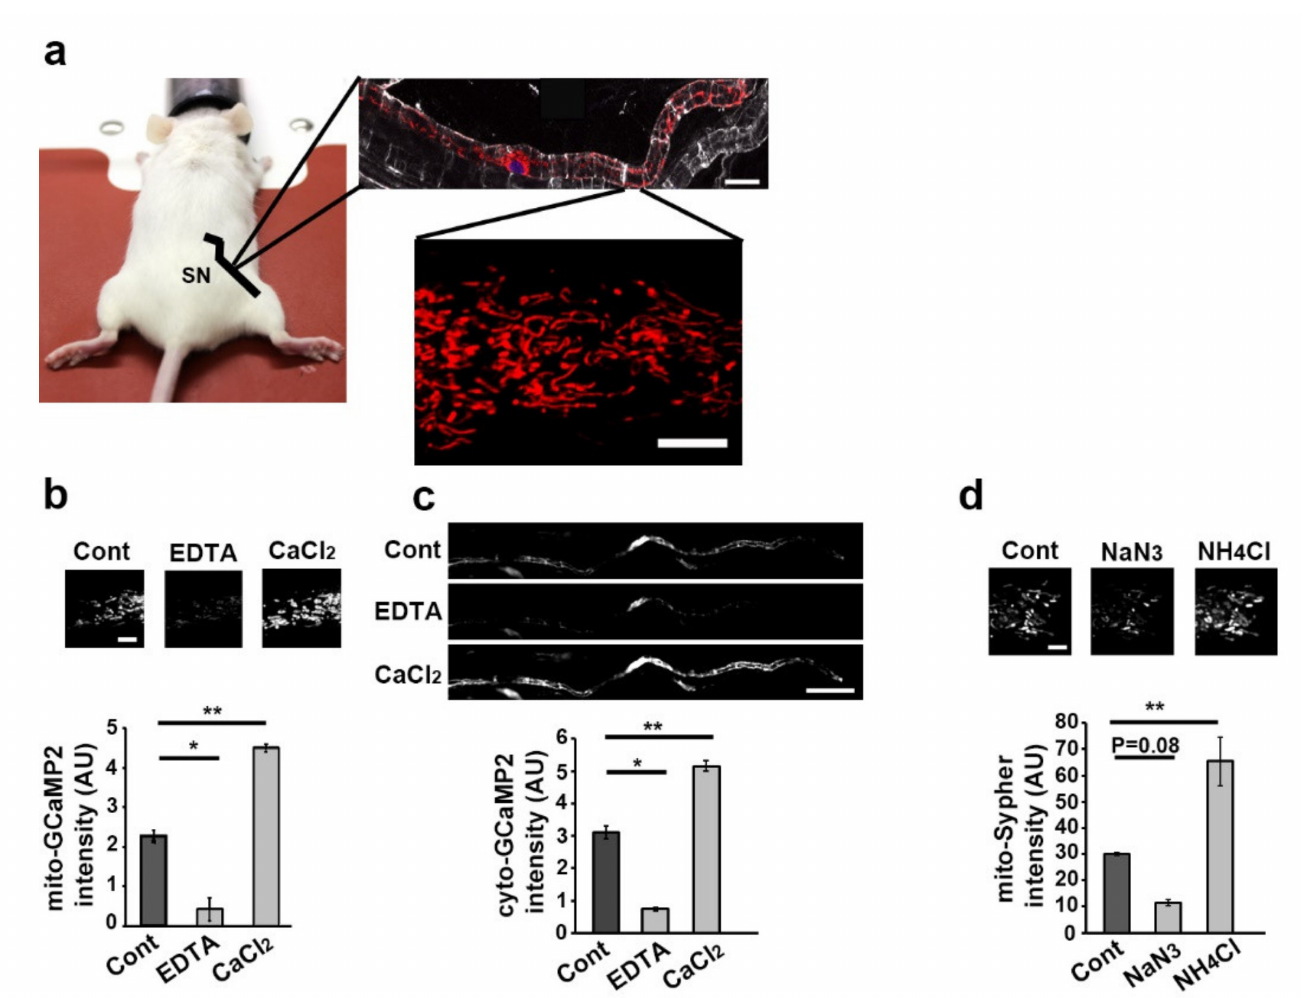
Figure 1. Live imaging technique and fluorescent probes validation ( a )—Schematic representation of the imaging technique used in this work. The sciatic nerve (SN) of anesthetized mice illustrated by the black line was exposed under the lens of a multiphoton microscope. Myelinating SC, stained for E-cadherin (white), contains mitochondria labelled through adenovirus-delivered mito-Dsred2 expression (red) in particular around the cell nucleus labelled with TOPRO3 (blue) (scale bar= 10 µ m). This technique allows the selective in vivo multiphoton imaging of mitochondria in some parts of living SC (scale bar = 5 µ m. Same magnification for all pictures.). All mice were 8 to 11 weeks old. ( b ) Mouse sciatic nerves expressing mito-GCaMP2 were incubated in a bath containing Leibovitz’s L15 medium without (Cont) or with EDTA (1 mM) or calcium chloride (CaCl 2 , 100 µ M). Probe fluorescence was imaged (upper panels pictures, scale bar = 5 µ m. Same magnification for all pictures.) and measured (lower panel graph). ( c ) Mouse sciatic nerves expressing cyto-GCaMP2 were incubated in a bath containing Leibovitz’s L15 medium without (Cont) or with EDTA (1 mM) or calcium chloride (CaCl 2 , 100 µ M). Probe fluorescence was imaged (upper panels pictures, scale bar = 50 µ m. Same magnification for all pictures.) and measured (lower panel graph). ( d ) Mouse sciatic nerves expressing mito-Sypher were incubated in a bath containing Leibovitz’s L15 medium without (Cont) or with sodium azide (Na3, 3 mM pH 3.2) or ammonium chloride (NH4Cl, 30 mM pH 8). Probe fluorescence was imaged (upper panels pictures, scale bar = 5 µ m. Same magnification for all pictures.) and measured (lower panel graph). Error bars show SEM. Statistical tests are one-way ANOVA comparing the control with each other condition. * p < 0.05, ** p <